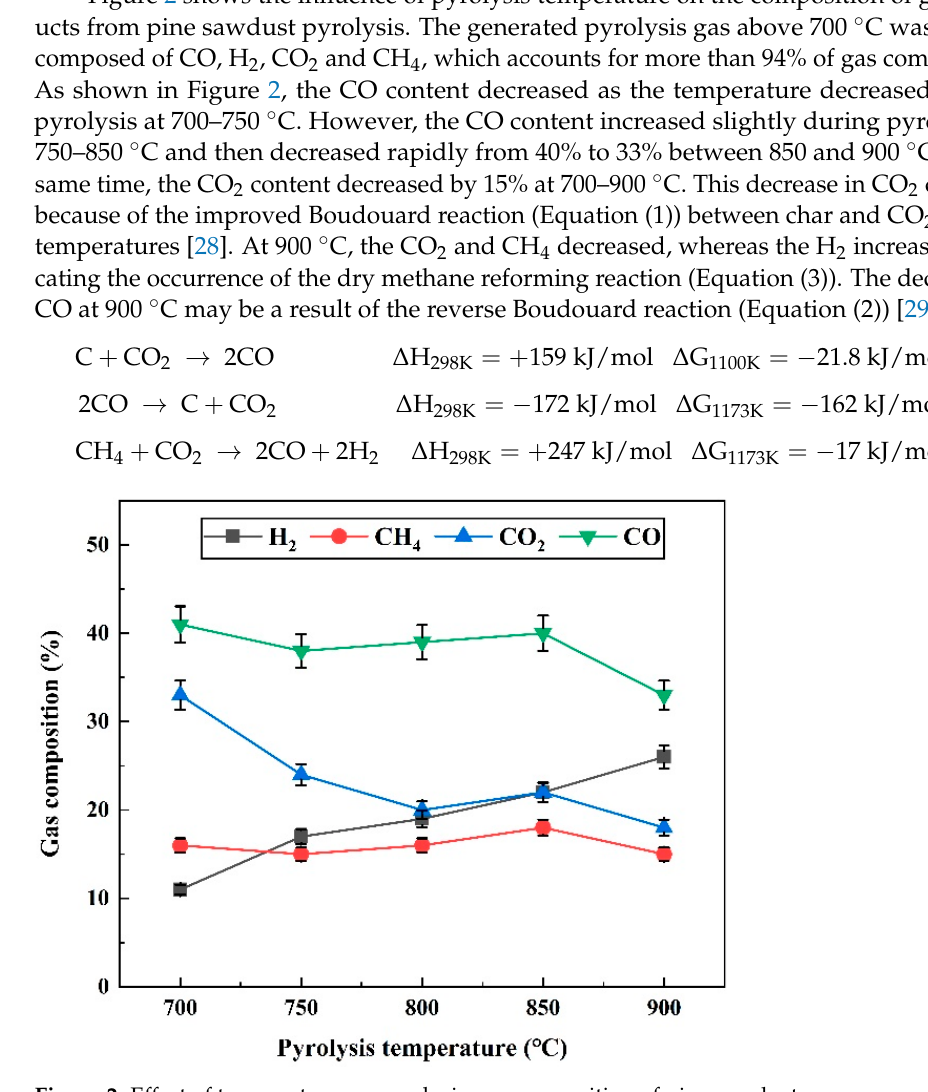
Figure 2. Effect of temperature on pyrolysis gas composition of pine sawdust.